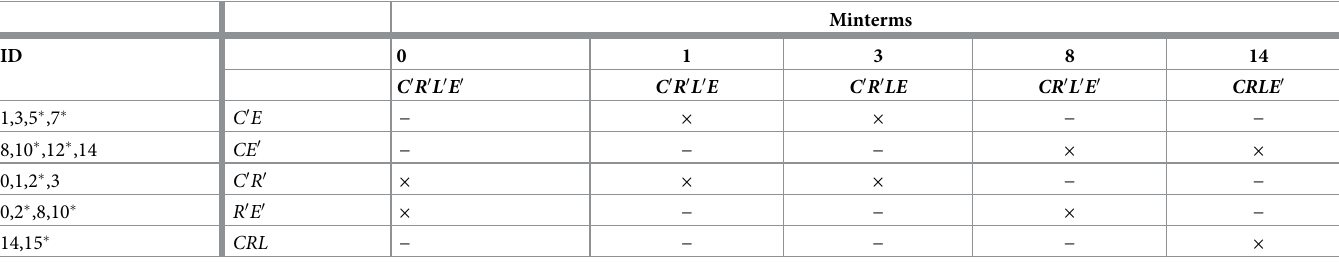
Table 5. Prime implicant chart for Doe’s data presented in Table